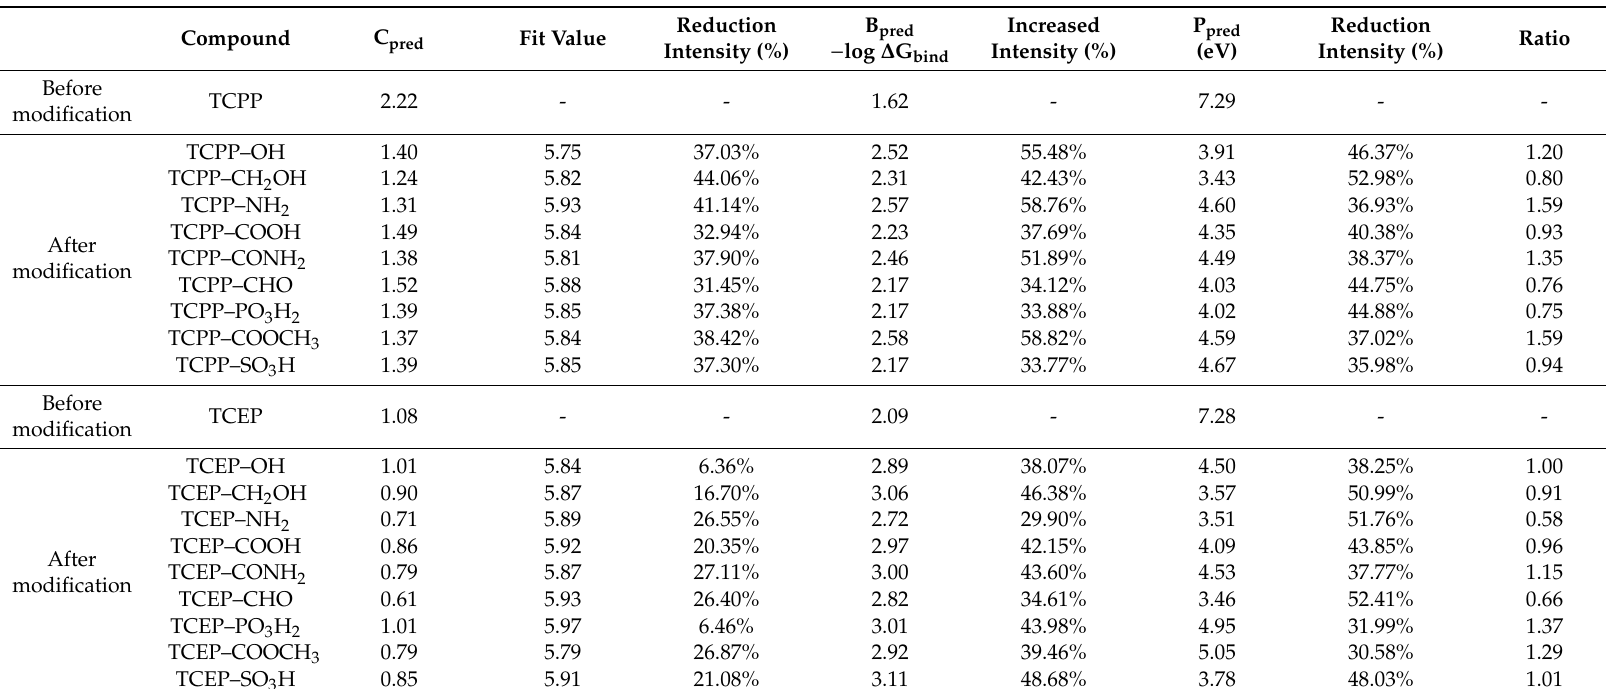
Table 5. Predicted values and variation degree of comprehensive and single biodegradation / photodegradation e ff ect models of OPFR